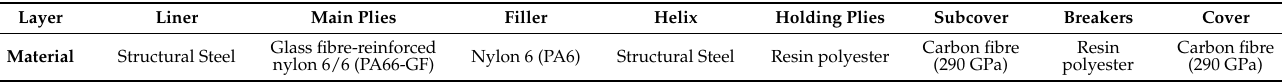
Table 2. Material consideration for reeled hose layers.